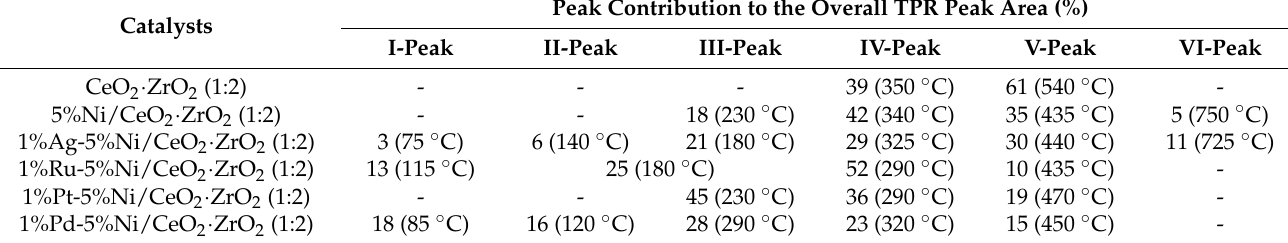
Table 3. Reduction data for the monometallic Ni and bimetallic 1% (Ag, Ru, Pt, Pd)-5% Ni catalysts after calcination in an air atmosphere at 400 ◦ C for 4h.